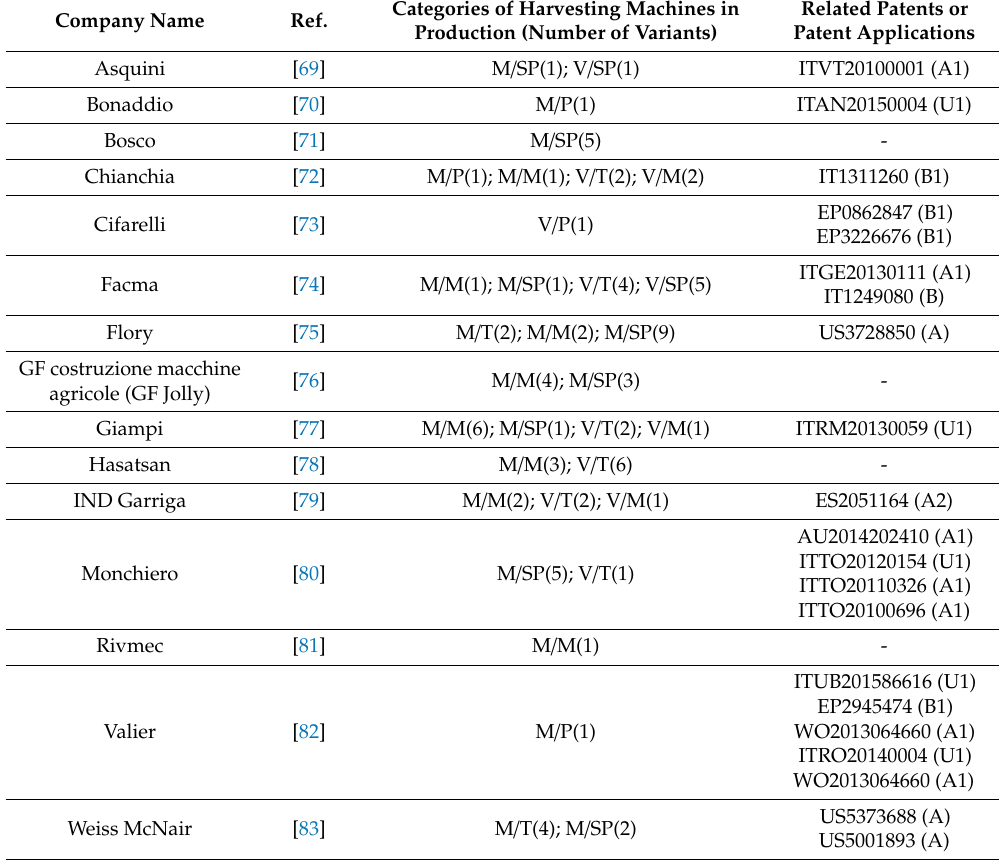
Table 2. Main companies / manufacturers cited in the literature and / or applicants of